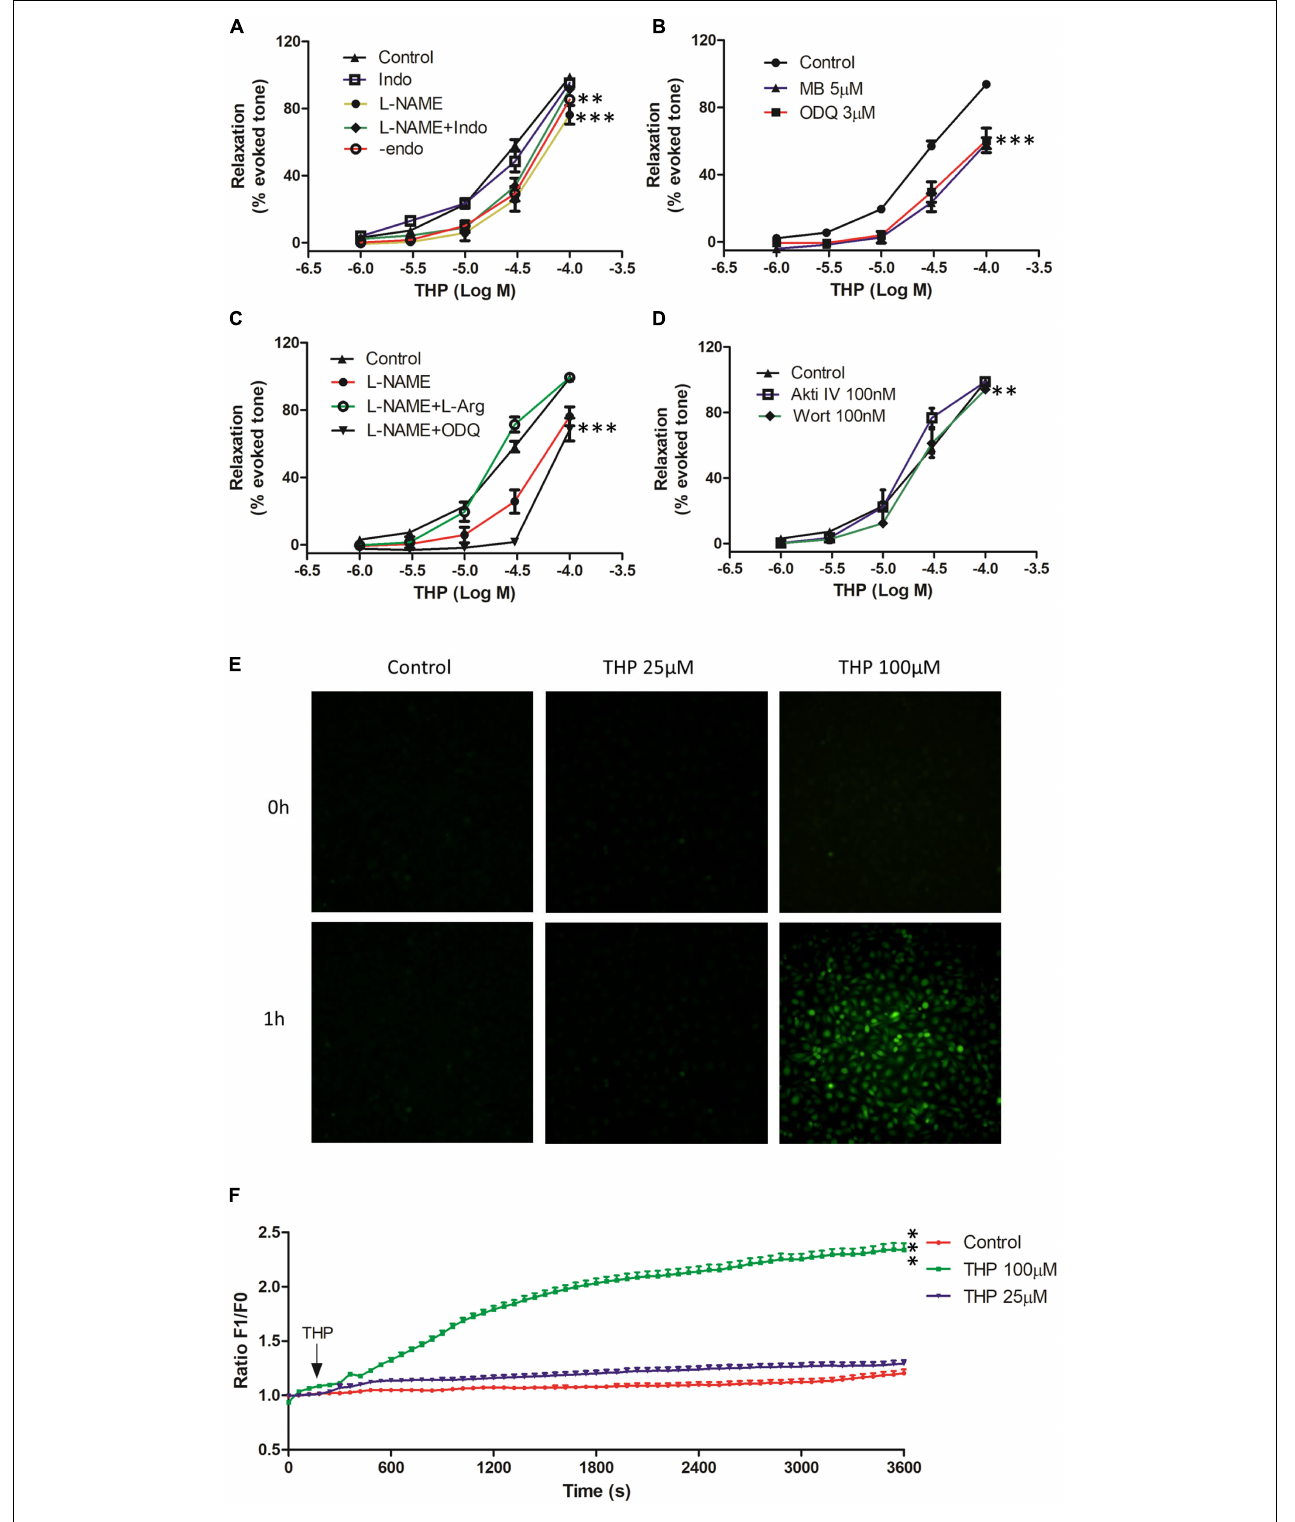
FIGURE 2 | Tetrahydropalmatine-induced vascular relaxation was dependent on endothelium and related to nitric oxide (NO) production and bioavailability. The rat aortas were contracted by Phe (1 µ M). (A) The effects of eNOS inhibitor (L-NAME, 100 µ M), COX2 inhibitor (Indo, 1 µ M) or mechanical removal of endothelium